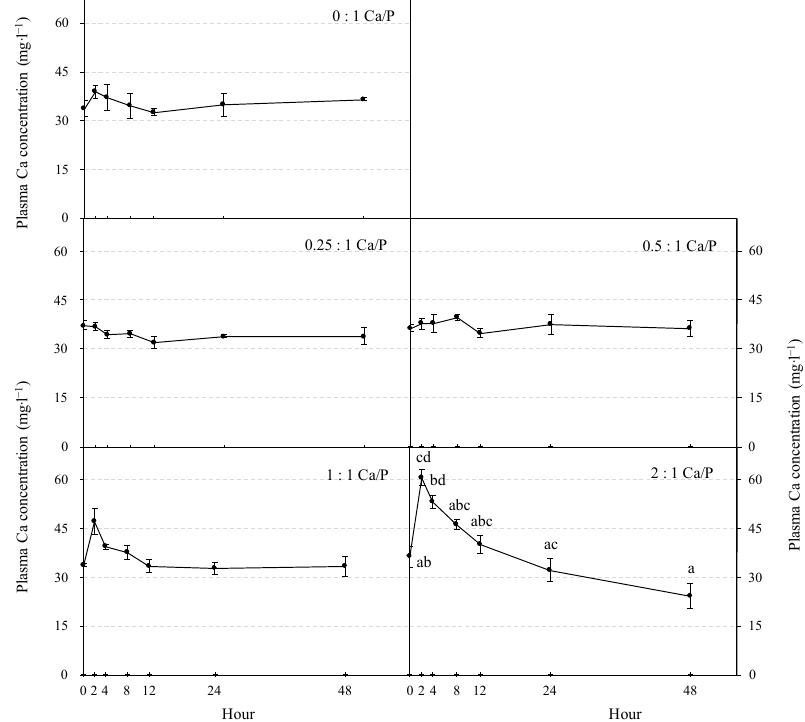
Figure 2. Plasma calcium (Ca) concentration of hybrid sturgeon ( Huso dauricus ♀ X Acipenser schrenckii ♂ ) after being intubated with 100 mg P·kg − 1 BW at different Ca/P ratios. Different letters indicate significant differences among the different time points in each treatment ( p < 0.05).